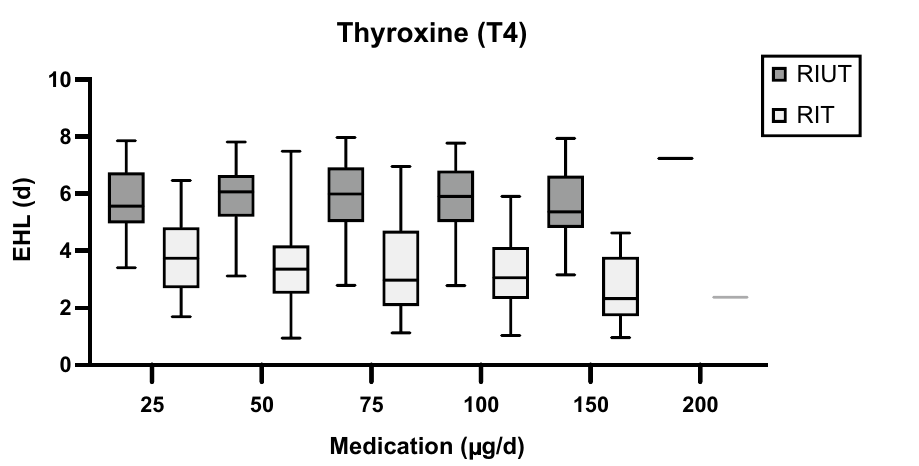
Figure 3. Development of pre- and intratherapeutic EHL depending on the dose of